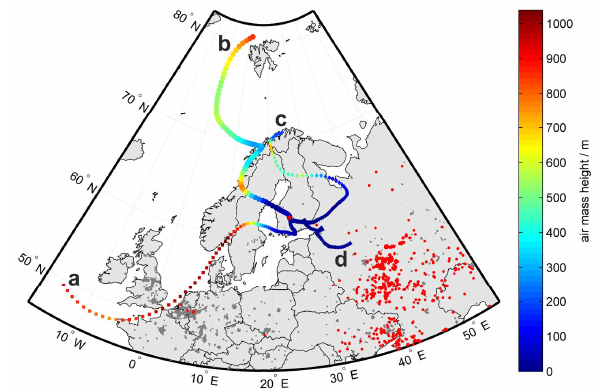
Fig. 3. 96h backward trajectory analysis of four different days (a– d) using the NOAA HYSPLIT model. (a) to (d) refer to the average intervals in Fig. 1 (arrival time 14:00LT (UTC + 2) of the respective day). The red star marks the SMEAR station at Hyytiälä. MODIS fire data are 100% CI fire spots between 18 July 2010 and 29 July 2010. Land, borders and populated areas are based on Natural Earth shapefiles (http://www.naturalearthdata.com).